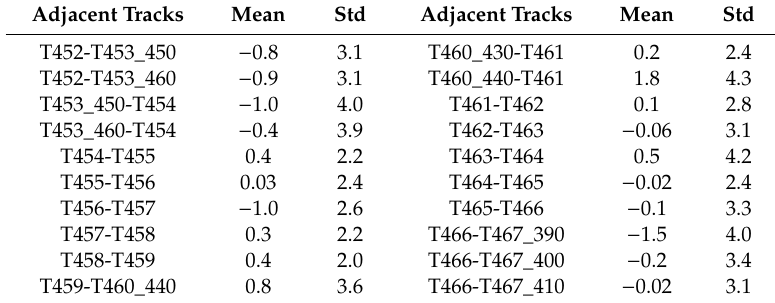
Table 3. Mean and standard deviation (std) of the average deformation rate difference in the overlapping areas of adjacent tracks.